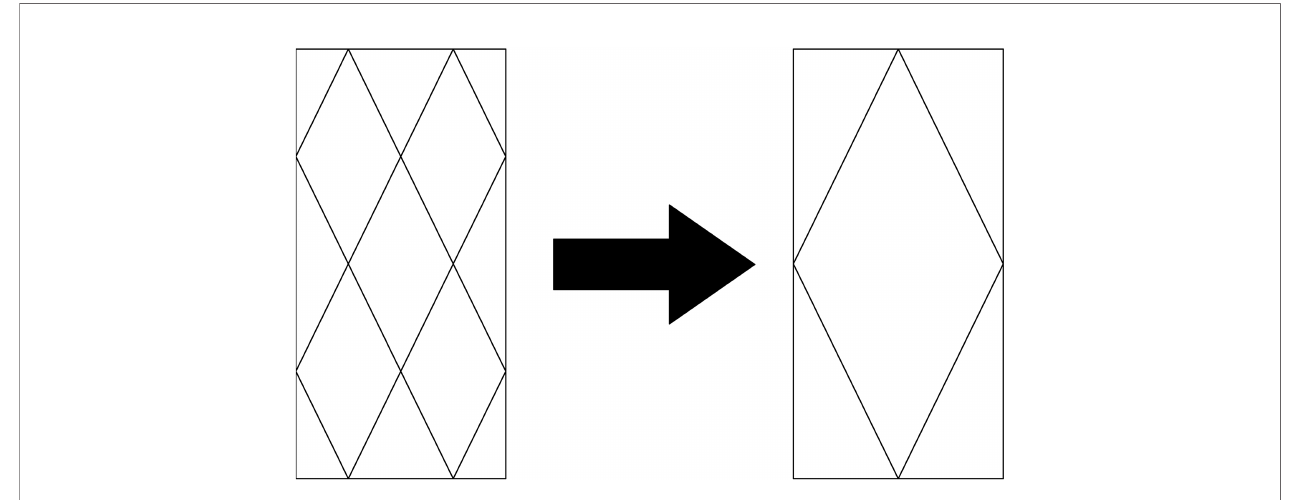
FIGURE 3 | Schematic diagram of the mesh grouping